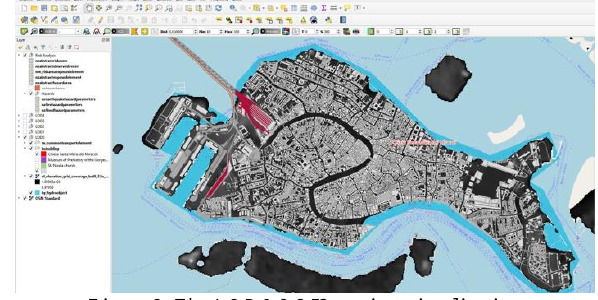
Figure 3. The LOD0 QGIS project visualization.